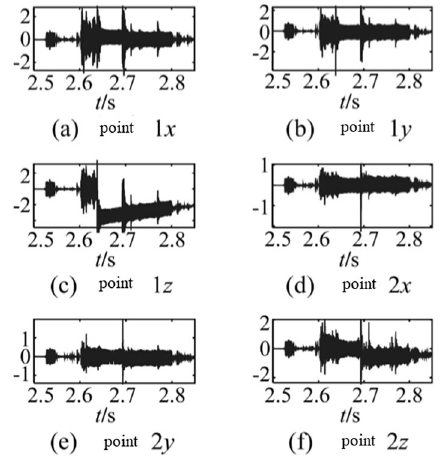
Figure 1. Accelerations at each measurement point from different directions. ( a ) Acceleration response signals in x direction of point 1. ( b ) Acceleration response signals in y direction of point 1. ( c ) Acceleration response signals in z direction of point 1. ( d ) Acceleration response signals in x direction of point 2. ( e ) Acceleration response signals in y direction of point 2. ( f ) Acceleration response signals in z direction of point